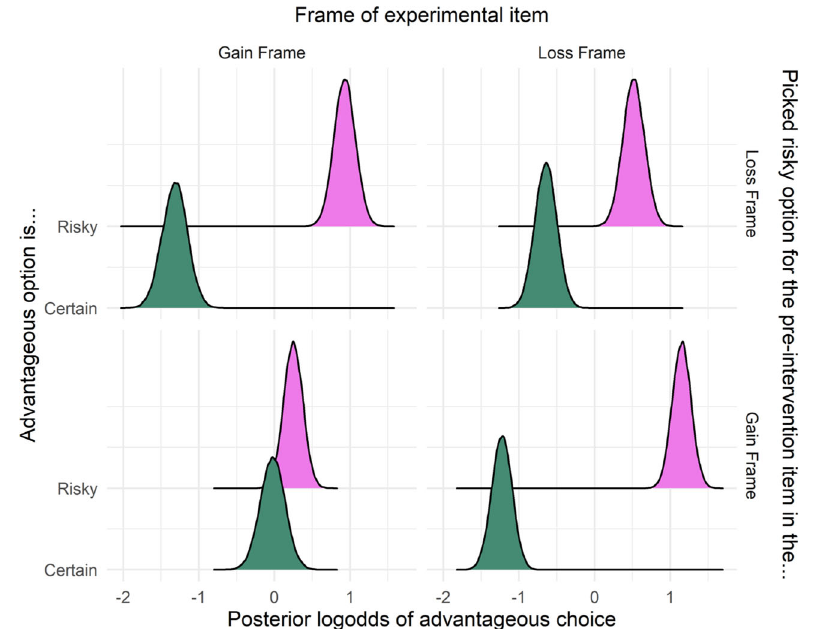
Fig. 3 Posterior log odds of advantageous choice as a function of risk. Posterior log odds of advantageous choice as a function of whether the pre- intervention choice was risky and whether the frame of the experimental item matched that of the pre-intervention item. Choosing the risky option pre- intervention is indicative of riskier choices post-intervention, regardless of whether the post-intervention frame is matching or not. In fact, pre-intervention choices are more predictive of risk preferences for experimental items with incongruent frames, as is illustrated by the fact that the distributions on the main diagonal are further apart than those on the counter